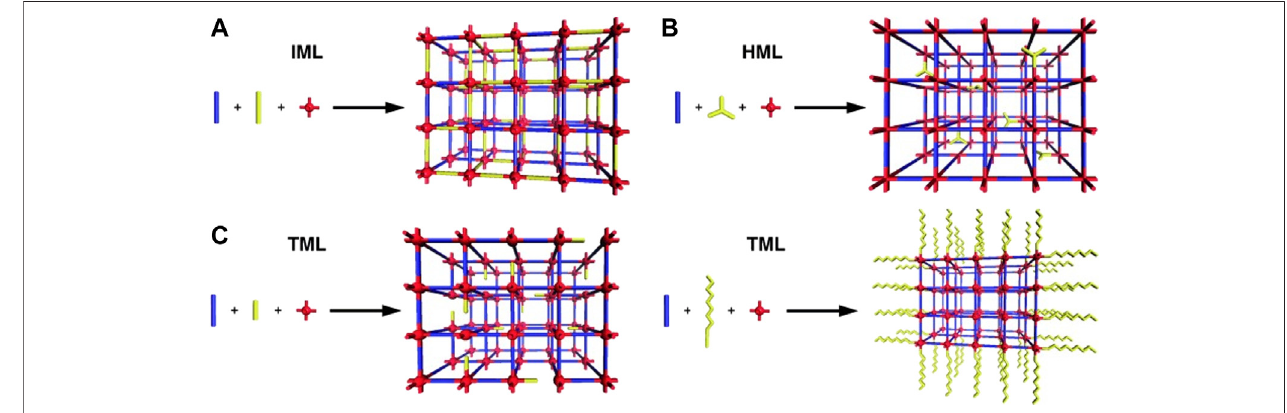
FIGURE 4 | Illustrations of the (A) isostructural mixed linker (IML), (B) heterostructural mixed linker (HML), and (C) two outcomes of truncated mixed linker (TML) approaches to framework functionalization (Bunck and Dichtel, 2013).